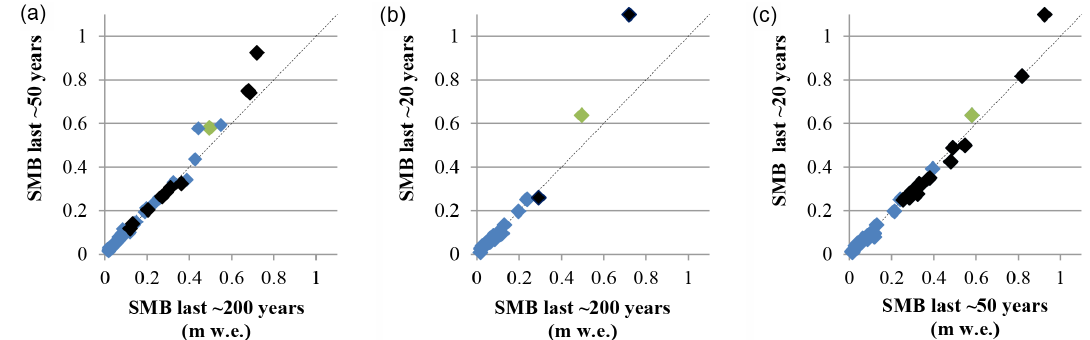
Figure 9. Comparison of SMB between different periods reconstructed for ice cores from the continent (see Table S1 for site location, references and exact periods): (a) the last ∼ 200 years and the last ∼ 50 years; (b) the last ∼ 200 years and the last ∼ 20years; (c) the last ∼ 50years and the last ∼ 20years. Coastal sites (<1500ma.s.l. and <100km away from the ice shelf) are shown in black, with the exception of our study site, IC12, which is shown in green. Inland sites are shown in blue. The 1 : 1 slope (0% change) is shown as a dotted